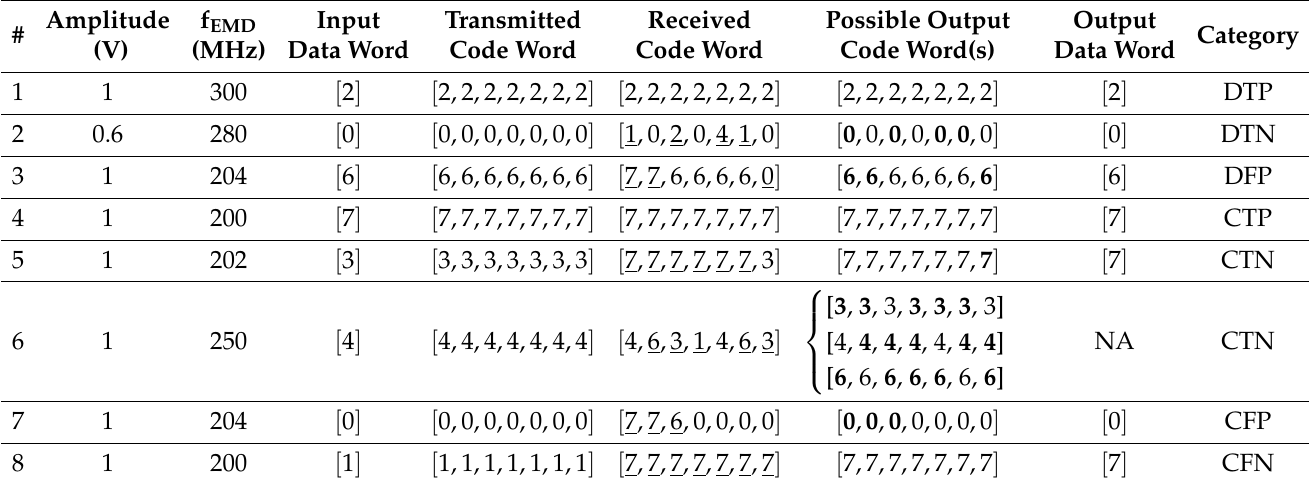
Table A1. Examples to demonstrate the impact of EMD on the data during the